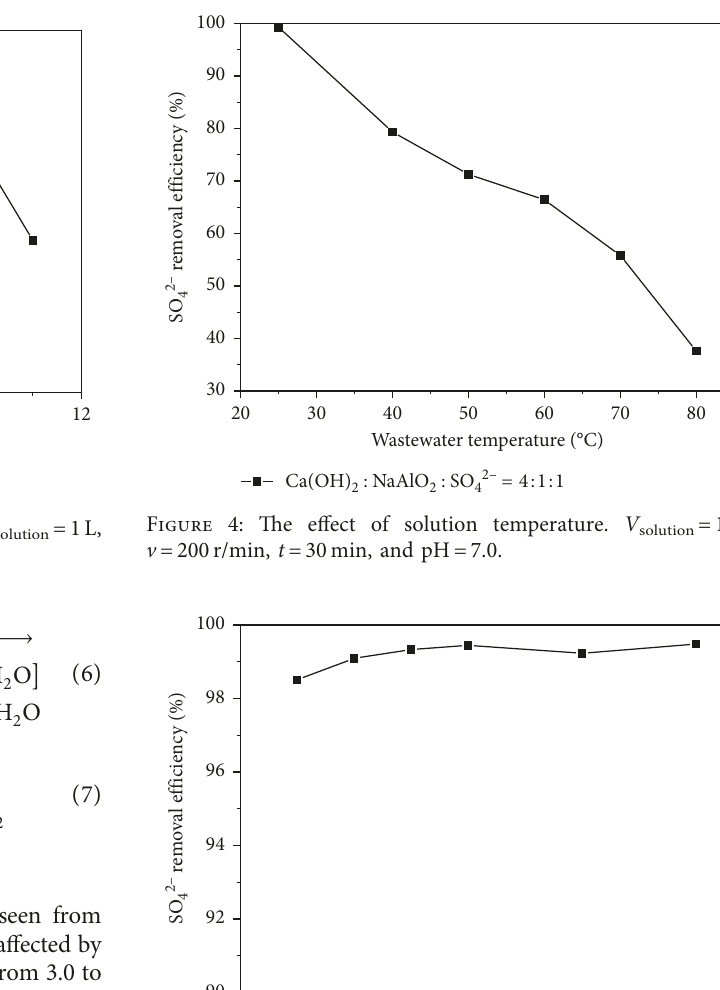
Ca(OH) 2 : NaAlO 2 : SO 42– = 4:1:1 Figure 5: The effect of reaction time. V T 25 ° C, and pH (cid:27) (cid:27)